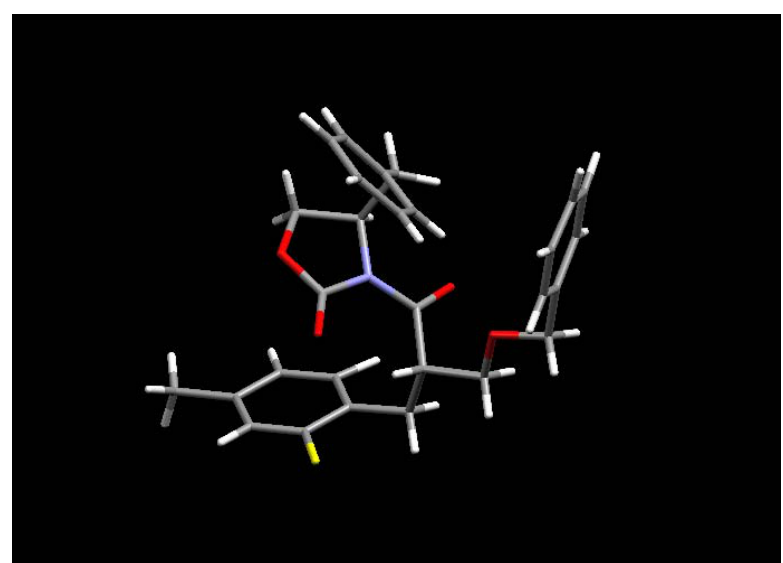
Figure 1. X-ray crystal structure of 17